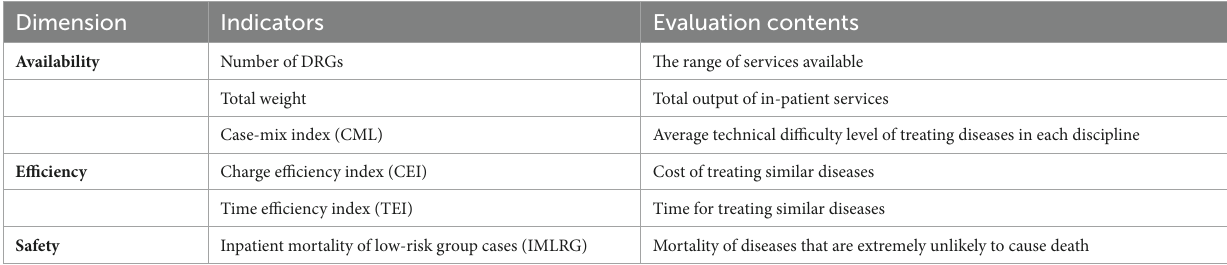
TABLE 1 Health system performance evaluation indicators based on DRGs.